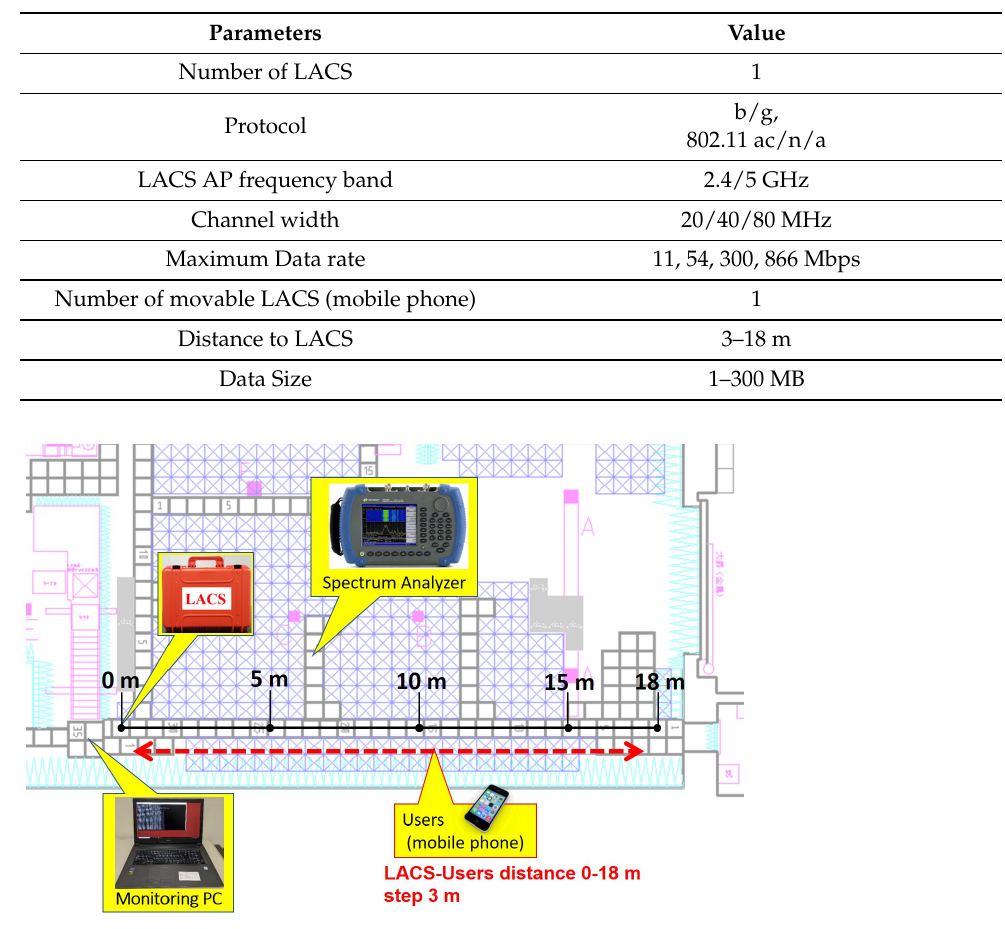
Table 1. Experiment Parameters.